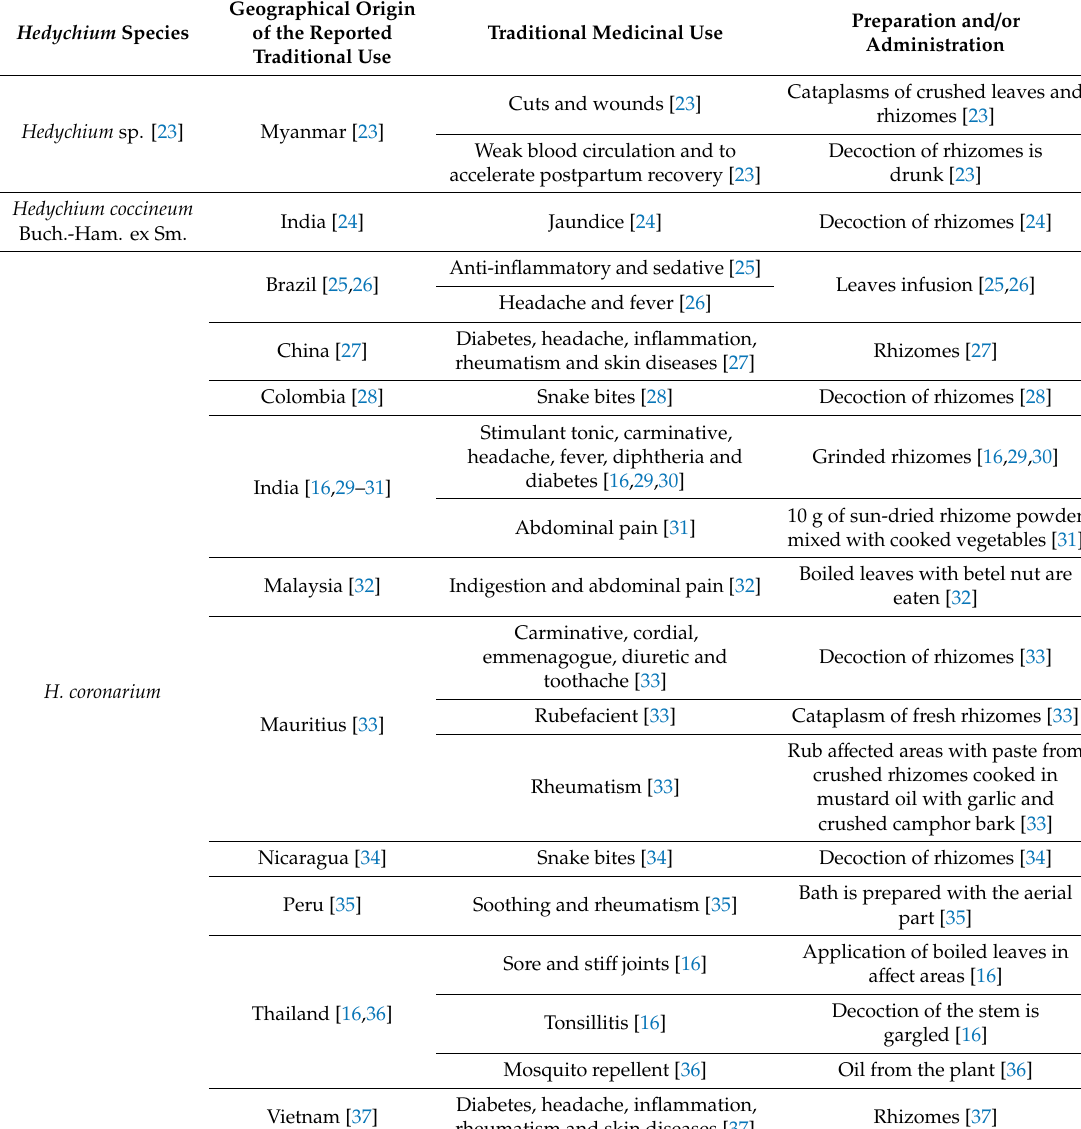
Table 1. Hedychium species with reported traditional medicinal